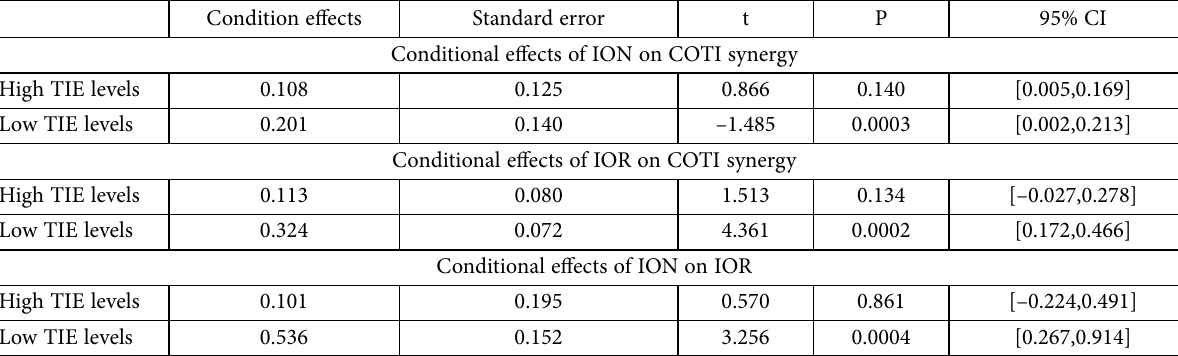
Table 5. Regression analysis results for the moderating